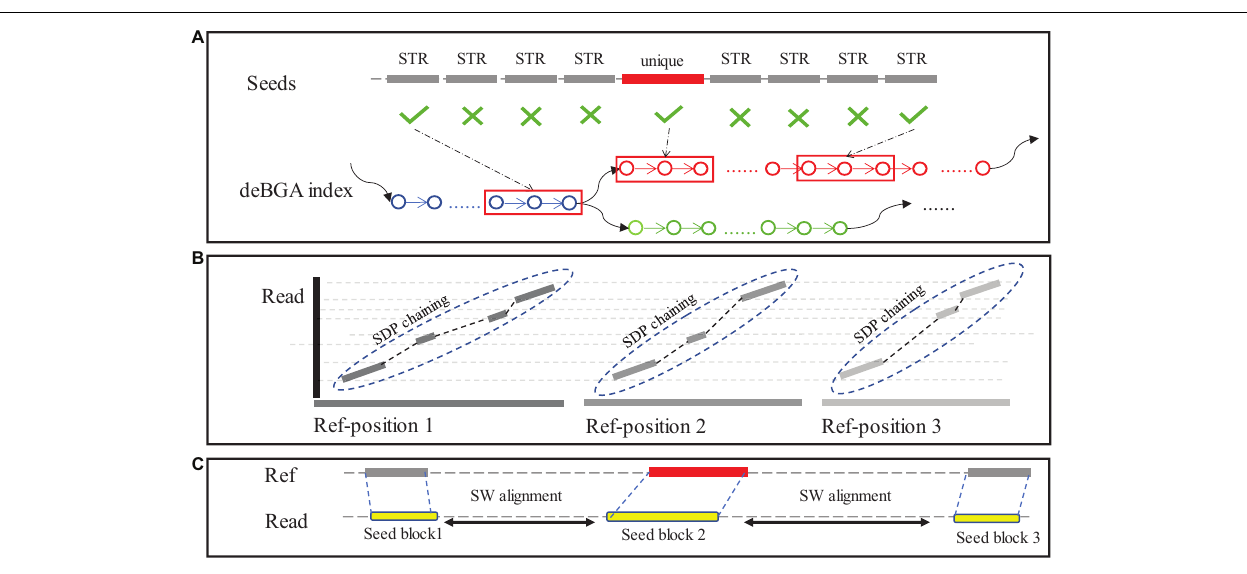
FIGURE 2 | The seeding-chaining-and-extension in the alignment step. (A) The seeds generated in “unique region” of reads are located in reference using deBGA index. (B) Seeds within UNITIG of deBGA index will be greedy chained to longer blocks, then those blocks will be mapped to reference and chained again using SDP. (C) Sequence between chained blocks will be aligned using NW